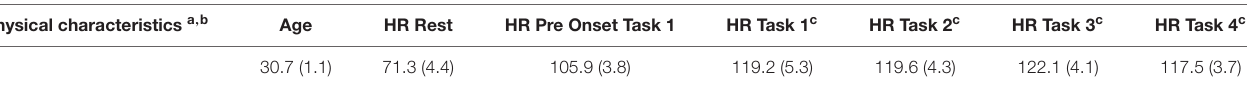
TABLE 3 | Physical characteristics. Physical characteristics a ,